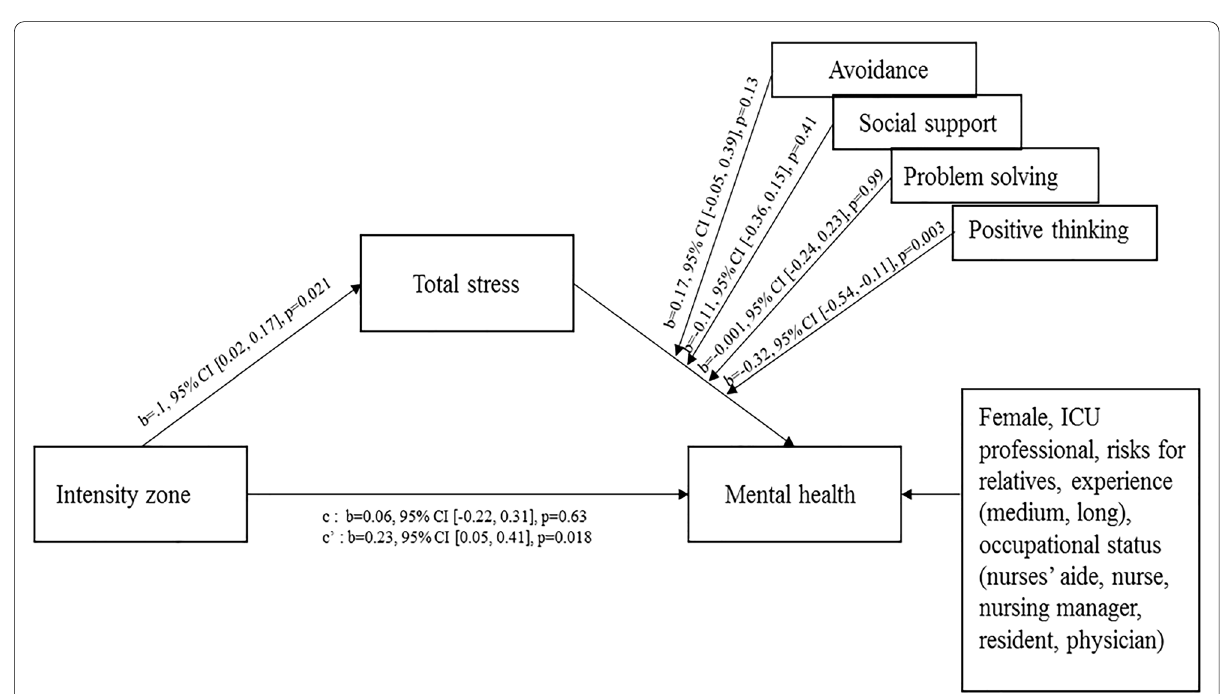
Fig. 2 Mediation and moderation analysis of the relationship between the epidemic intensity zone and mental health through total stress scores. *ICU professional: b 0.88, [0.63, 1.12], p < =